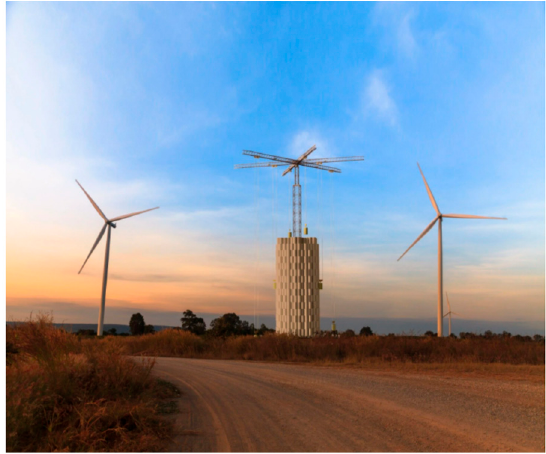
Figure 16. Full-scale project prediction.